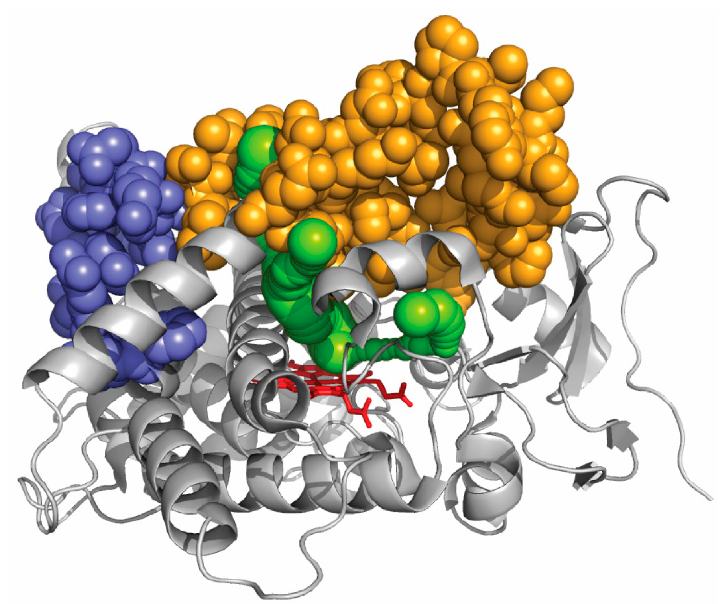
Figure 4. Visualization on CYP1A1 crystal structure of the regions mutated and the ligand access channels. The protein structure is represented as cartoon with the heme represented as red sticks. CAVER channels are in green. The sequence segment that, when mutated, shows the same polycyclic aromatic hydrocarbon dual specificity as wild-type CYP1A enzymes is in purple. The sequence segment that, when mutated, shows an impact on the substrate specificity for hydrocarbon substrates is in orange. This later segment contacts the different CAVER channels. The key sequence elements that were identified in this work are precised in Urban et al. [100].